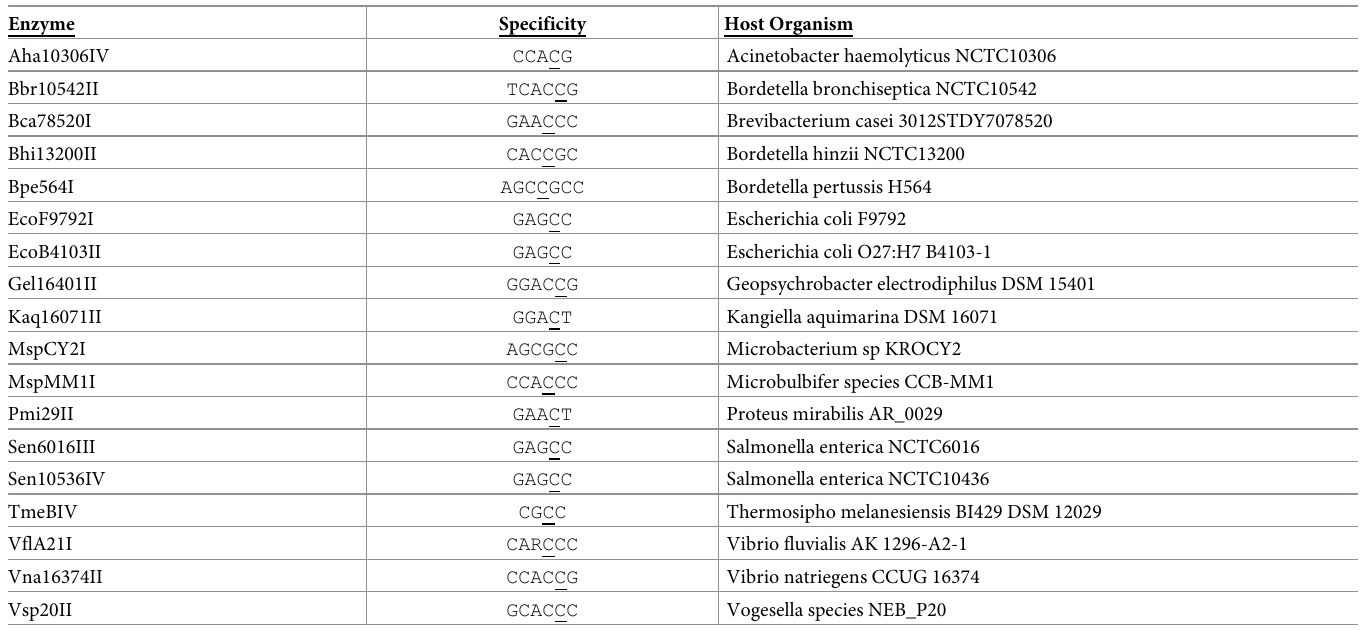
Table 4. Putative m4C Type III R-M